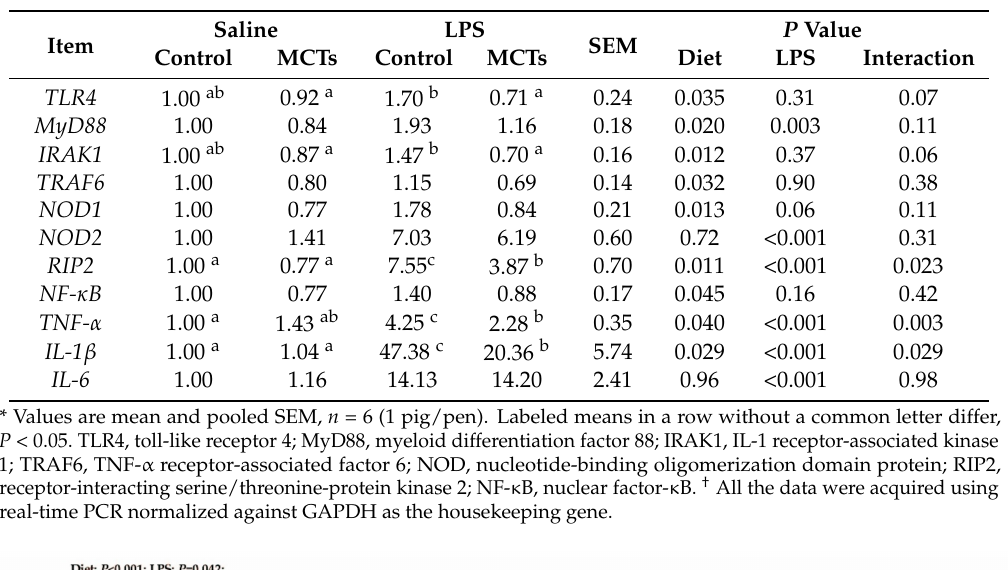
Table 2. Effect of medium-chain triglyceride (MCT) supplementation on mRNA expression of inflammation-related signaling molecules after 4-h LPS challenge in pigs * ,† .